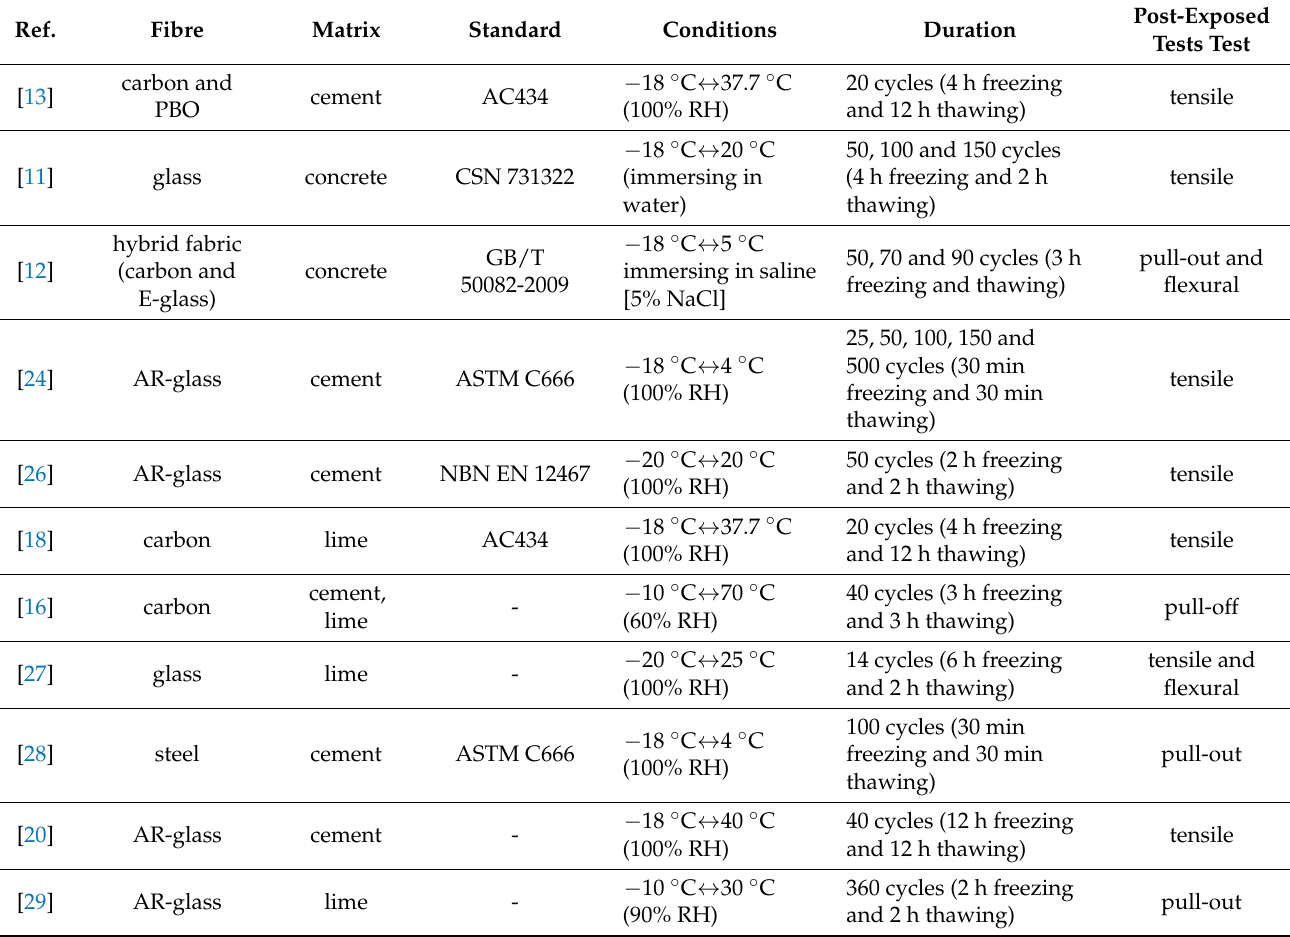
Table 2. Summary of literature on frost